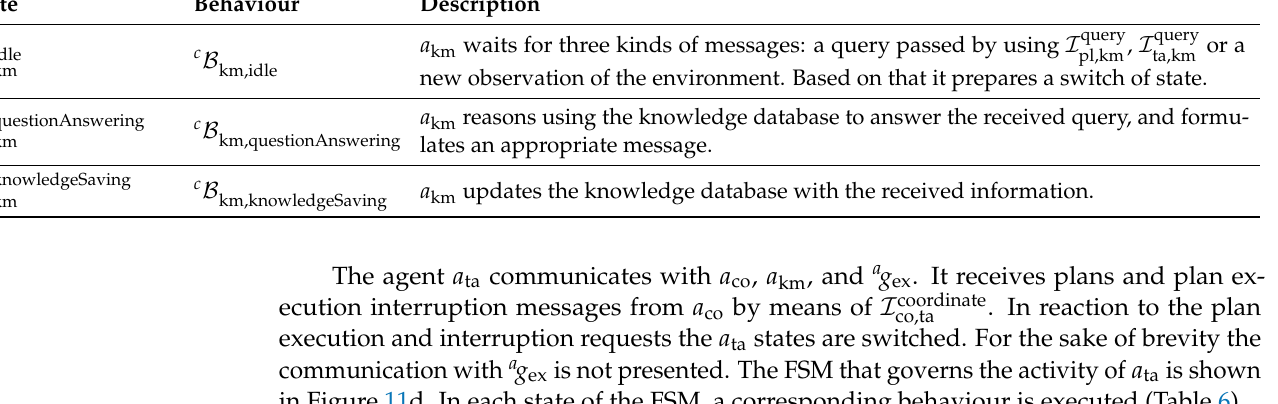
Table 5. Mapping of the states of c